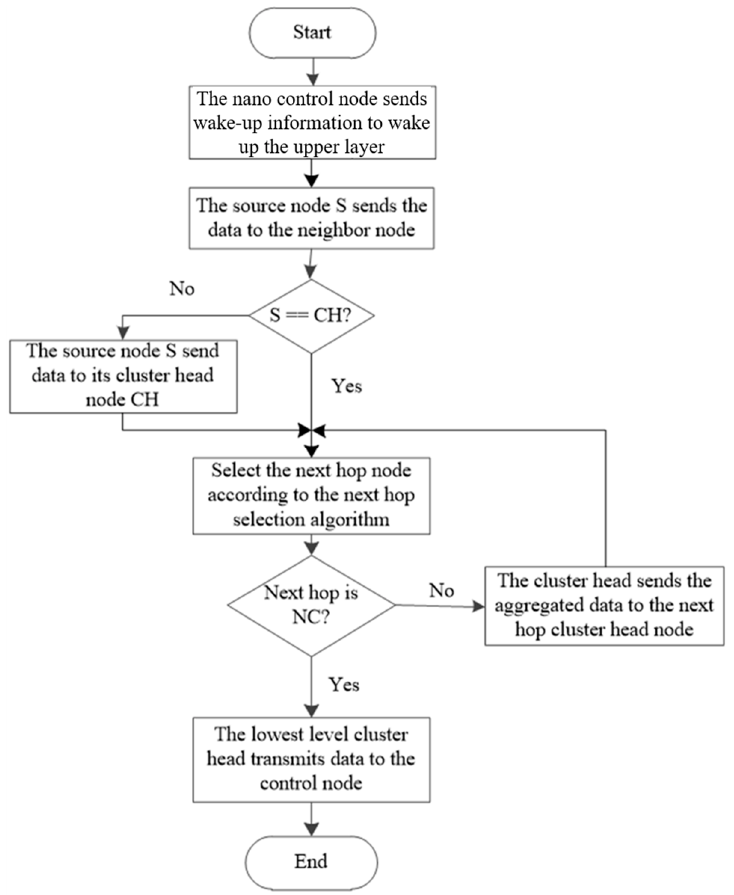
Figure 6. EBCR routing process.